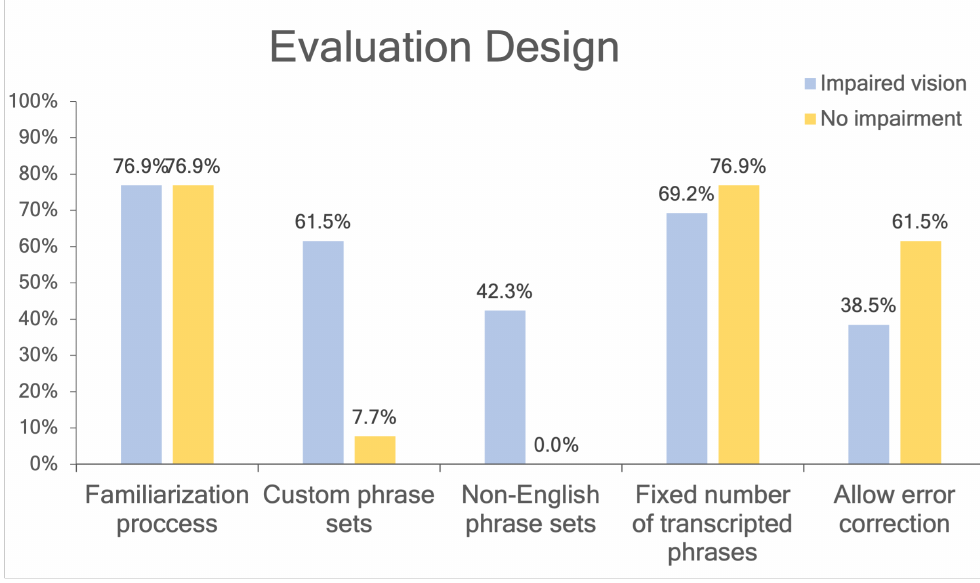
Figure 8. Evaluation design aspects for prototypes aimed at VIBPs and non-impaired